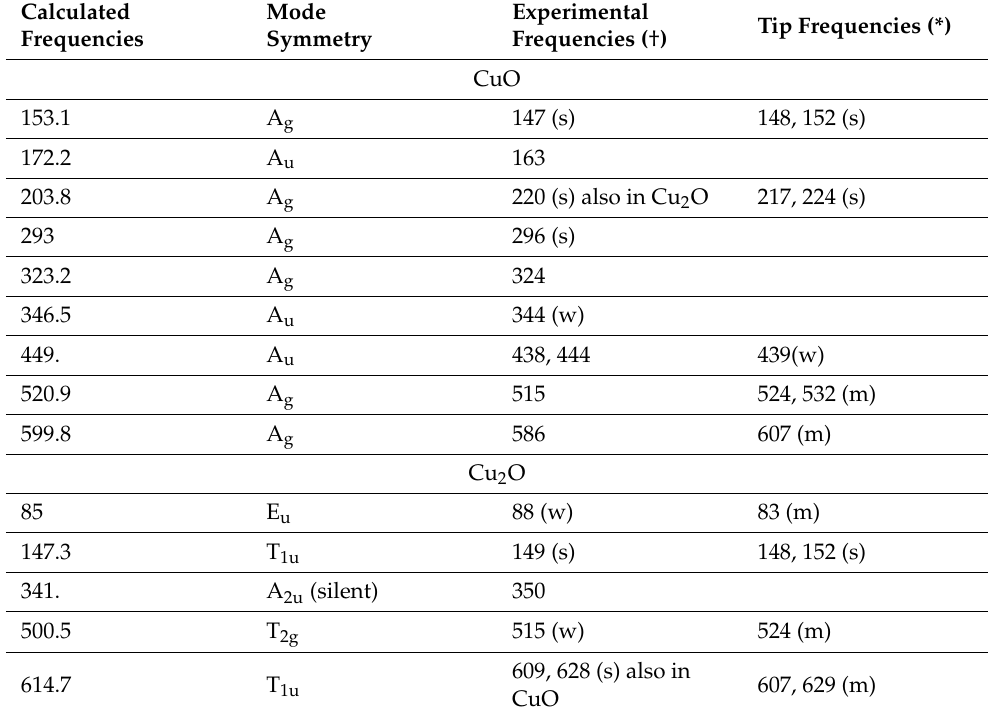
Table 1. Calculated and experimental vibrational frequencies of CuO and Cu 2 O reported from literature (†, Refs. [27,28,31,32]) and found in this work (*). Units are given in cm − 1 . s: strong intensity; m: medium; w: